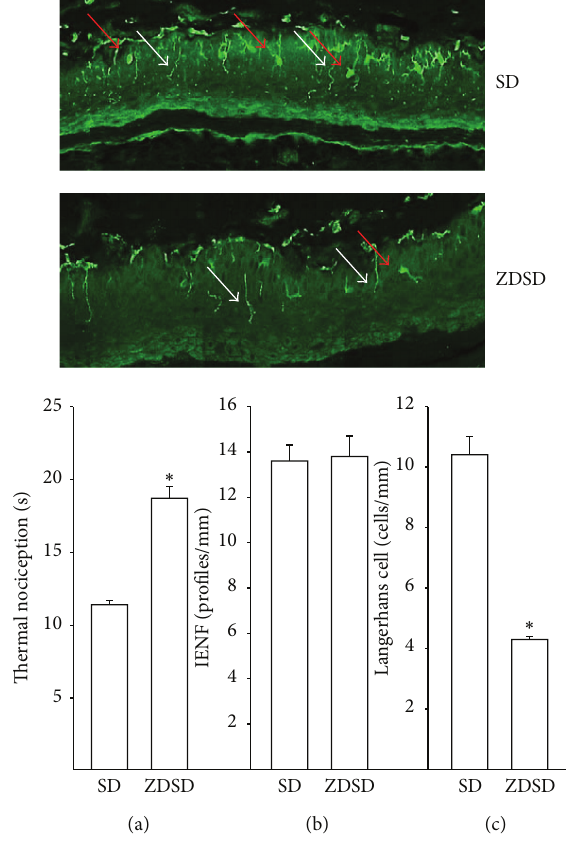
Figure 3: Thermal nociception, intraepidermal nerve fiber, and Langerhans cell density in age-matched Sprague Dawley and ZDSD rats. Thermal nociception (a), intraepidermal nerve fiber (b), and Langerhans cell (c) density were examined as described in the Methods section in Sprague Dawley (SD) and ZDSD rats. Inserts are representative images of skin from foot pads from Sprague-Dawley (left) and ZDSD (right) rats. The white arrows point out nerve fibers and the red arrows point out the Langerhans cell. The number of rats in each group was 10 and 9, respectively. Data are presented as the mean ± S.E.M. for thermal nociception in sec, intraepidermal nerve fiber as profiles per mm, and Langerhans cell as number of cells per mm. ∗ 𝑃 < 0.05 compared to Sprague Dawley rats.